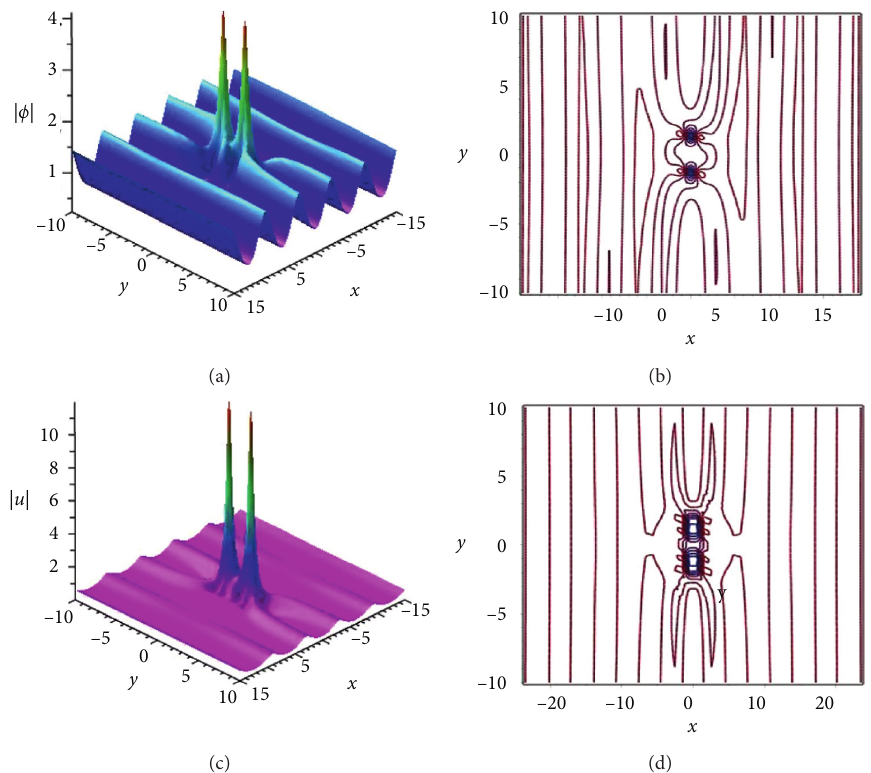
Figure 9: Semirational solutions constituting of two lumps and periodic line waves for the nonlocal Mel ′ nikov equation with parameters � − λ � 1 , λ � − λ � 2 ,P � 1 , Q � 0 , and η 0 κ � 1 , λ 1 2 3 4 5 5